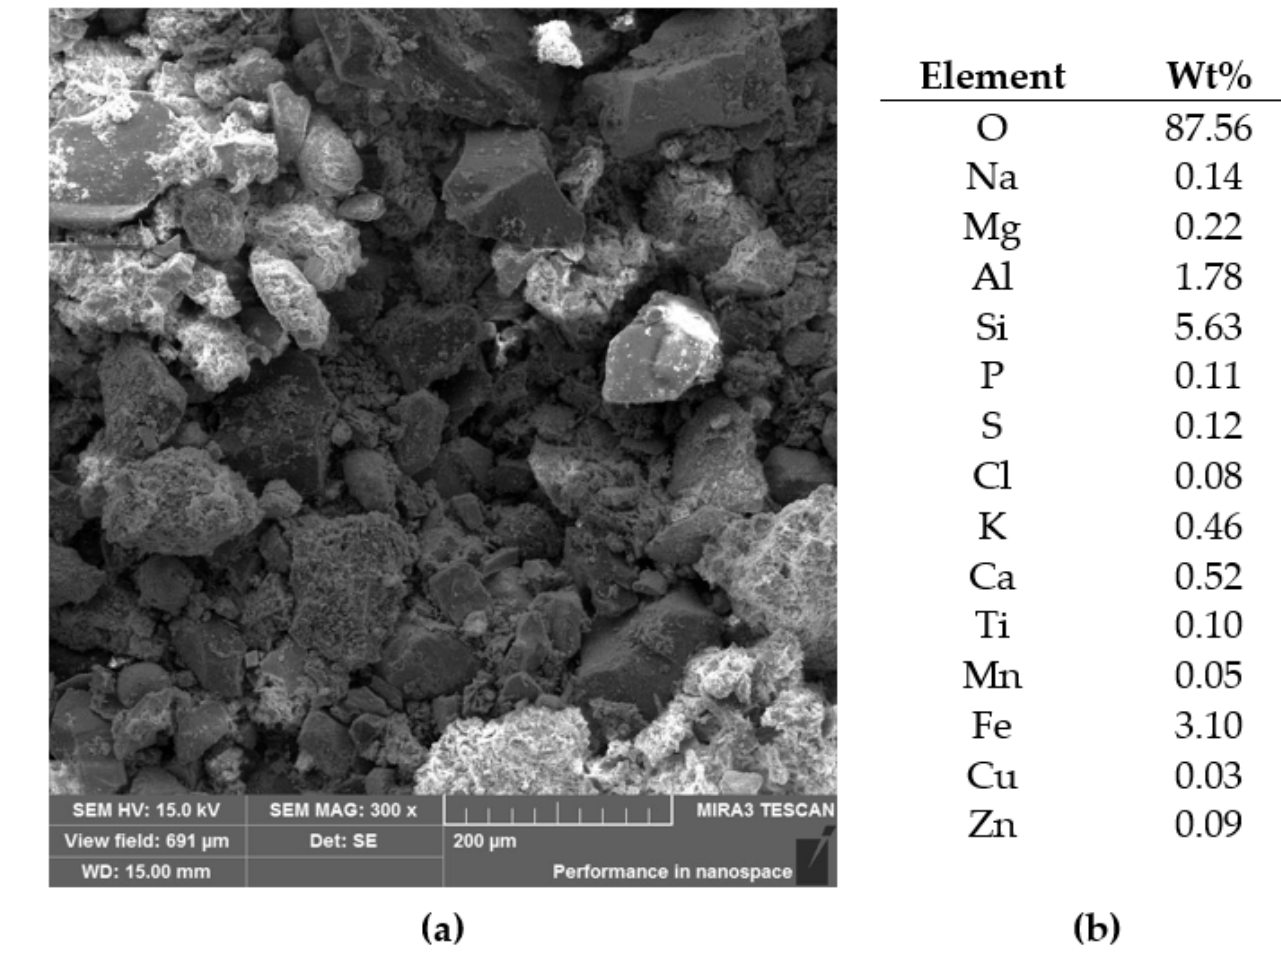
Figure 17. Sediment from the Kłodnica river, from specimen W2: ( a ) SEM-SE image and ( b ) elemental content from the whole shown area.